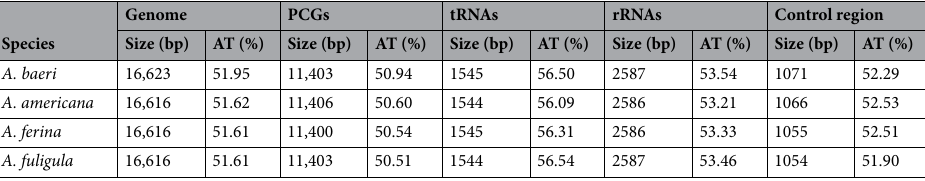
Table 1. Nucleotide compositions of the Aythya mitogenomes.